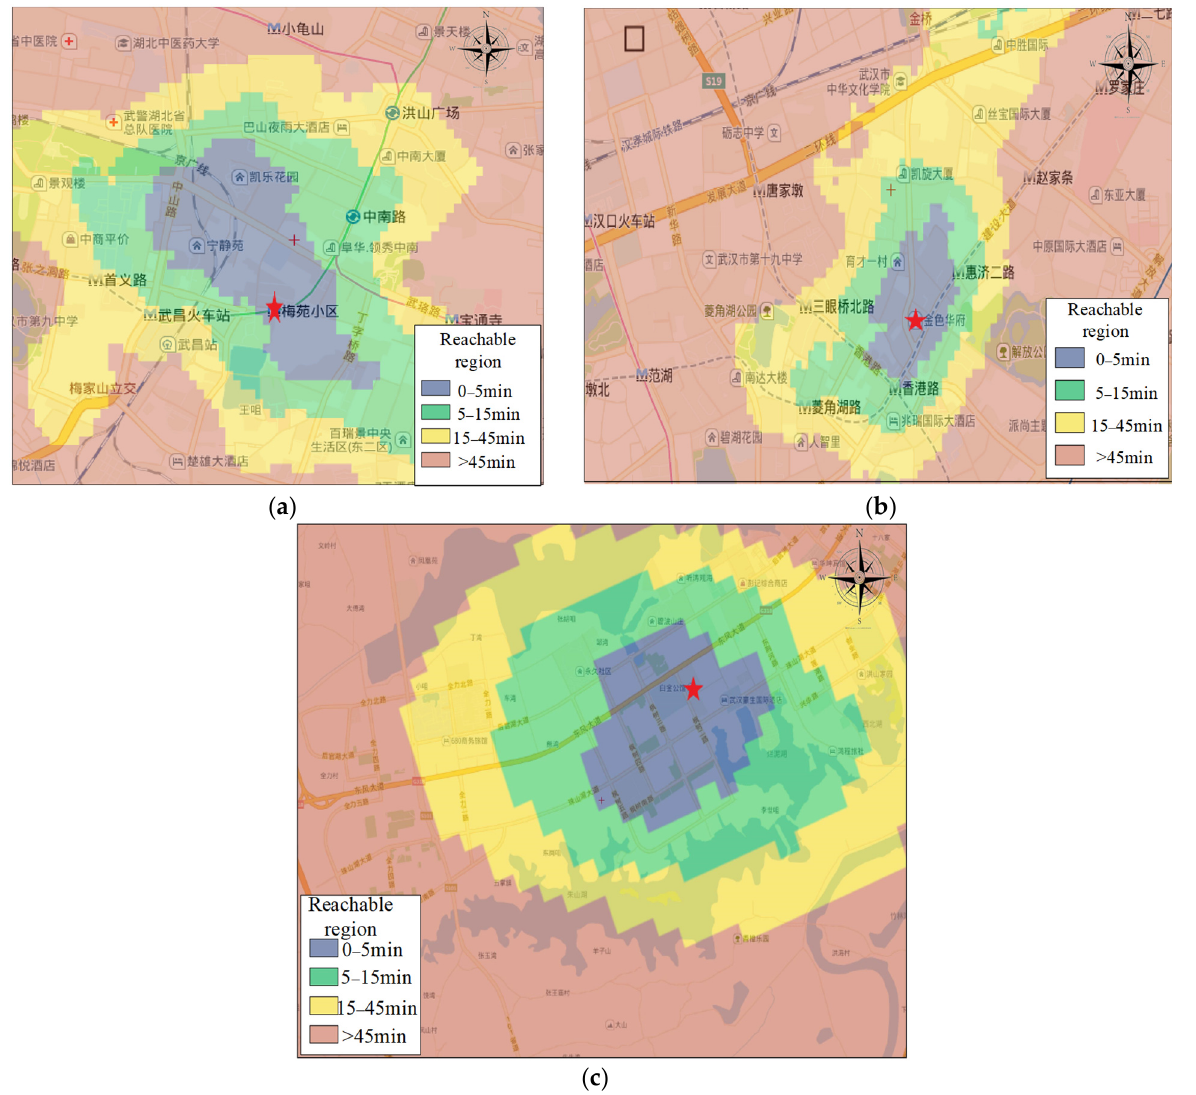
Figure 6. The reachable region of each community for the third trip pattern, ( a ) community in Wuchang district; ( b ) community in Jiangan district; ( c ) community in Caidian district.